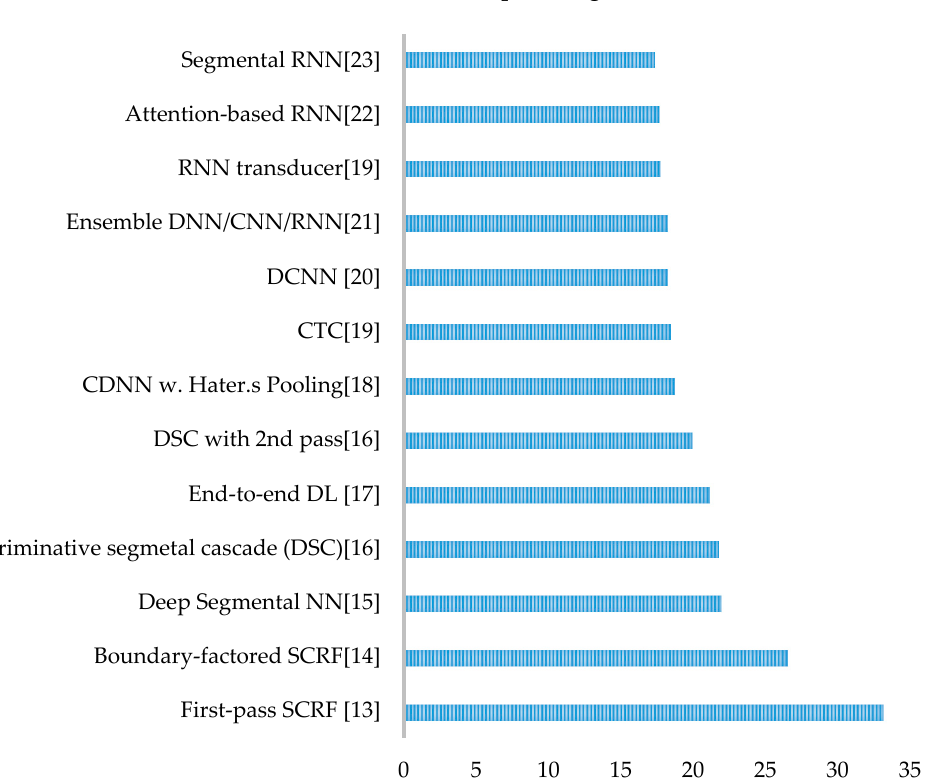
Figure 4. Phone error rate (PER) for TIMIT Acoustic-Phonetic Continuous Speech Corpus dataset [13–23].